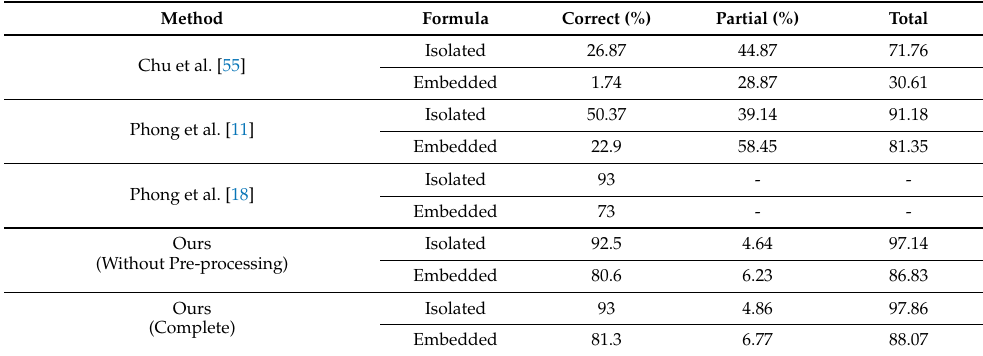
Figure 9. Performance evaluation of the proposed method on the ICDAR-2017-POD dataset. The green colour depicts the ground truth, while red denotes the predicted bounding boxes. ( a ) represents an example of both true positives and a single false positive case, whereas ( b ) shows three false positives with one false negative. Table 4. Performance comparison between our method and previous state-of-the-art approaches on the Marmot